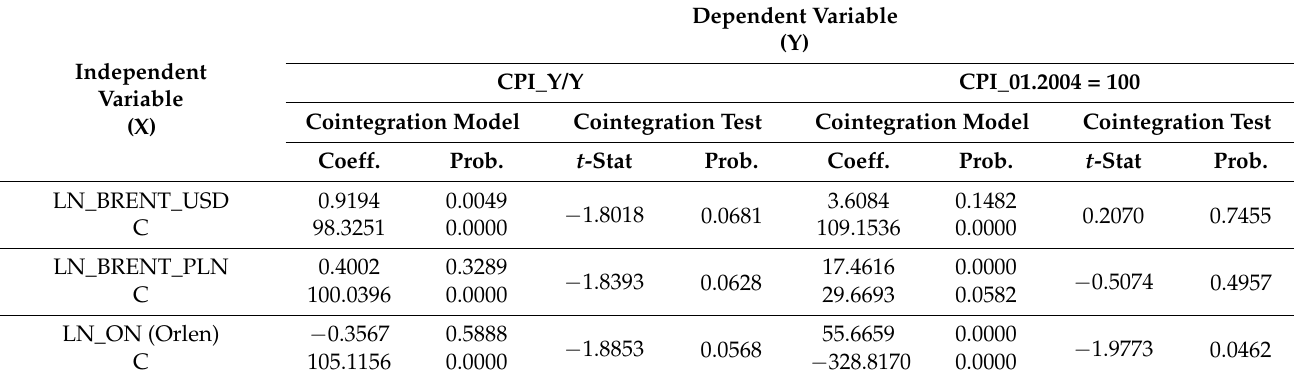
Table 5. Cointegrations models and tests